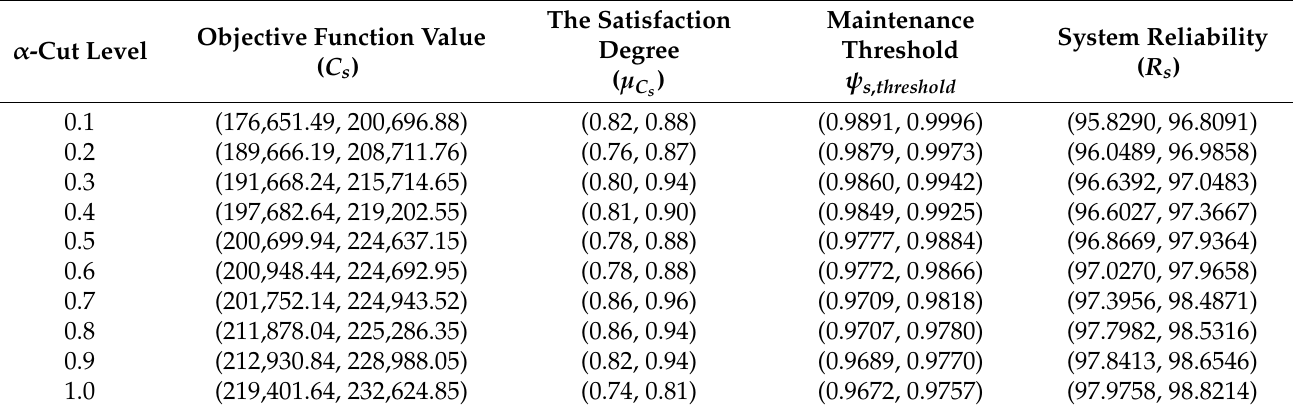
Table 6. Summary of experimental